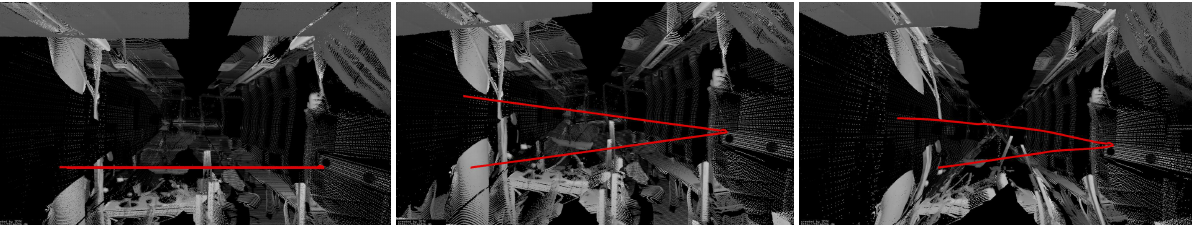
Figure 14. Linear trajectory without overlap between consecu tive scans. Left: Original data as recorded. Middle: Corrected point cloud with carefully selected parameters after applying a linear distortion. Right: Corrected point cloud with standard